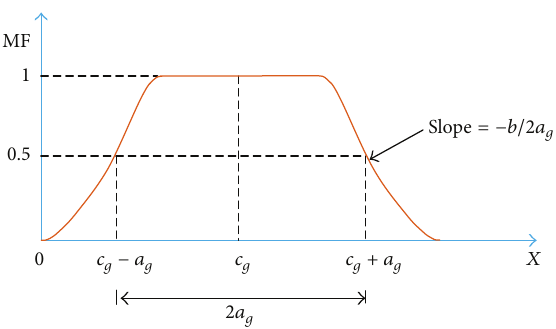
Figure 5: Bell-shaped membership function.